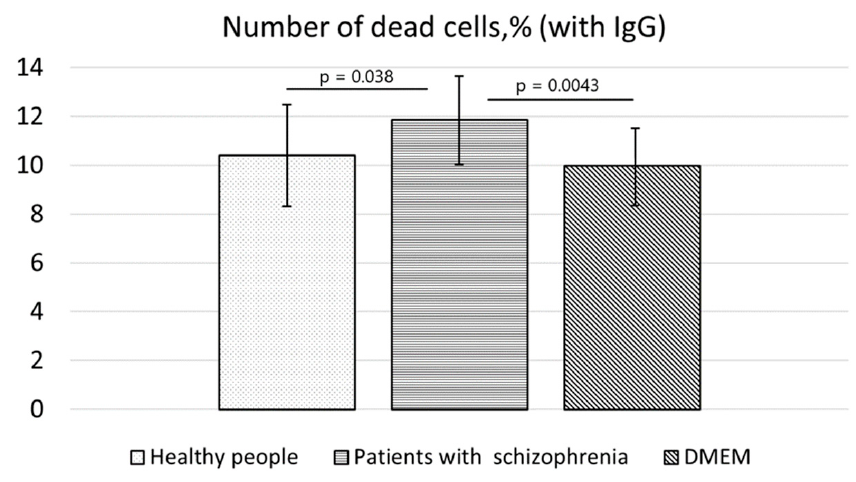
Figure 4. Percentages of dead SH-SY5Y cells after 24 h of incubation with IgG from schizophrenic patients or from healthy individuals or without antibodies (the culture medium alone).